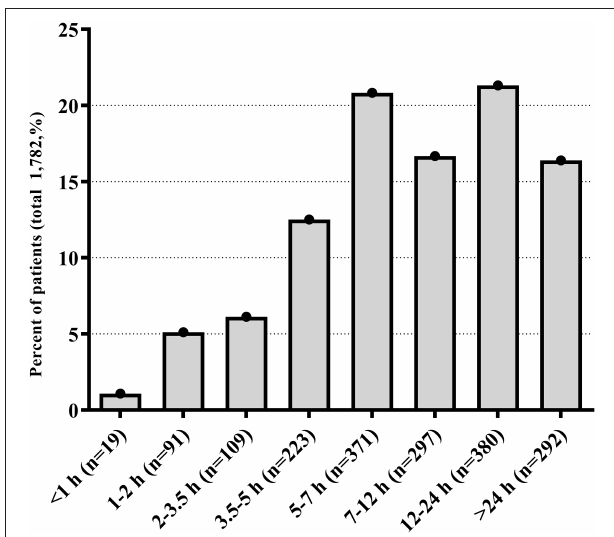
FIGURE 1 | Frequency distribution of prehospital delay time for patients with acute